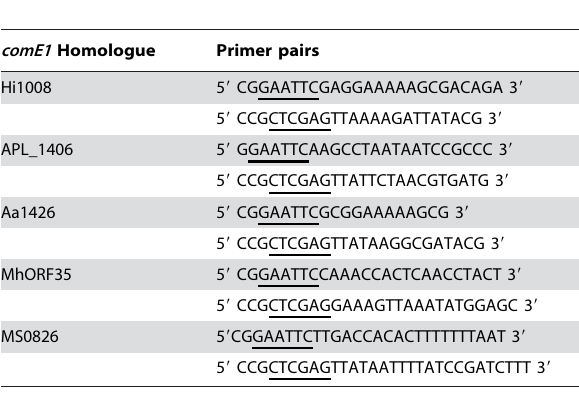
Table 1. Oligonucleotides used to amplify genes encoding homologues of ComE1. Restriction sites are